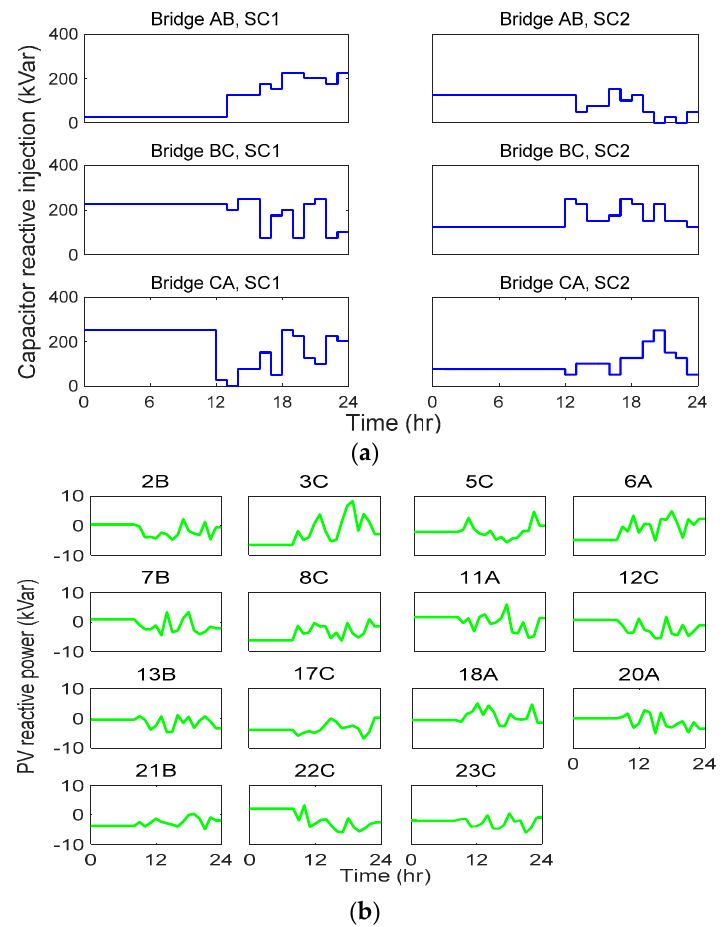
Figure 7. Optimal reactive injections after the proposed multi-stage technique over a 24-h period from ( a ) MV SCs, and ( b ) LV PV inverters.